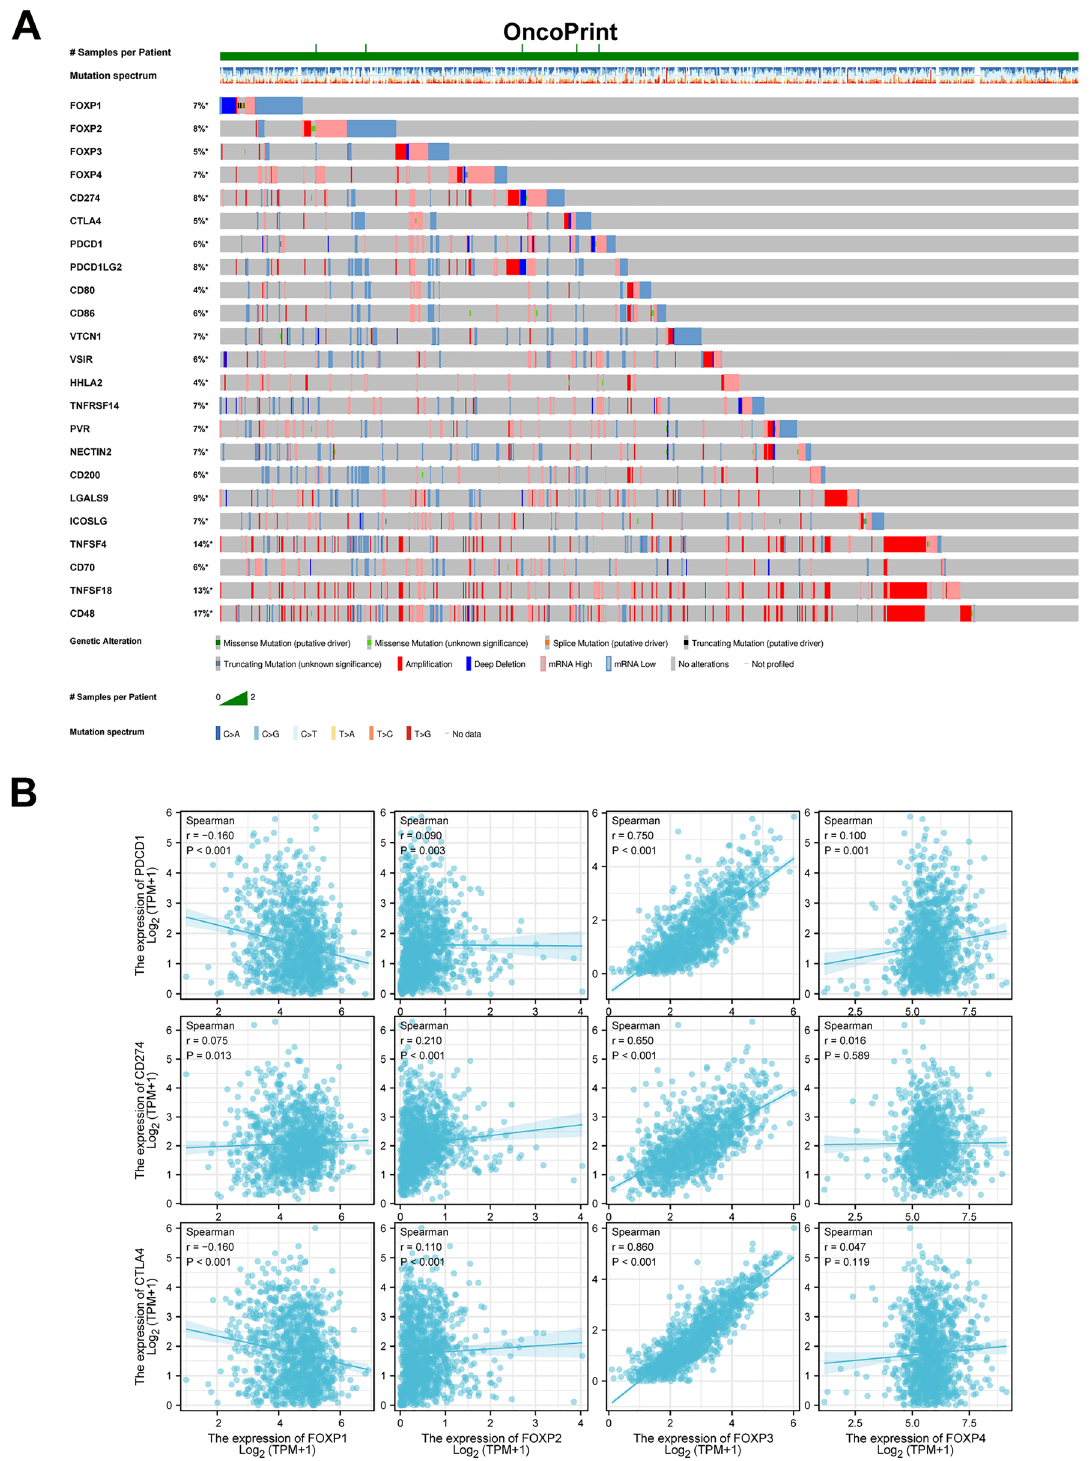
Figure 4. FOXPs and immune checkpoints mutation analysis and the relationship between the expression of FOXPs and immune checkpoints genes (PDCD1, CD274, CTLA4) in BRCA. ( A ) Landscape of FOXPs and immune checkpoint alteration in Breast Invasive Carcinoma (cBioPortal). ( B ) FOXP3 has a significant positive correlation with PDCD1, CD274, CTLA4, but FOXP1, 2, 4